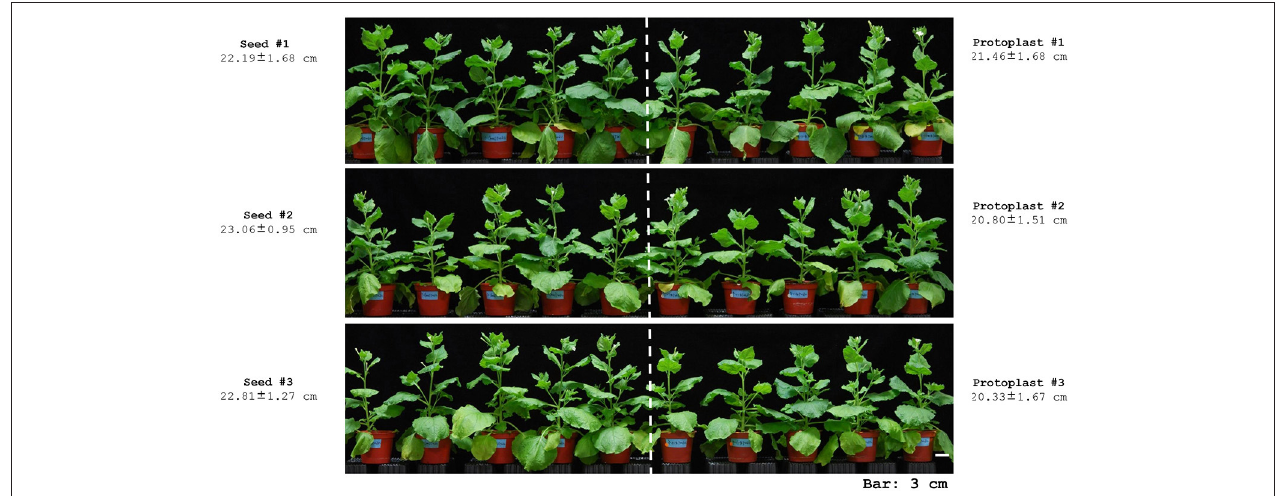
FIGURE 2 | Phenotypes of seed-derived seedlings and seedlings regenerated from protoplasts.